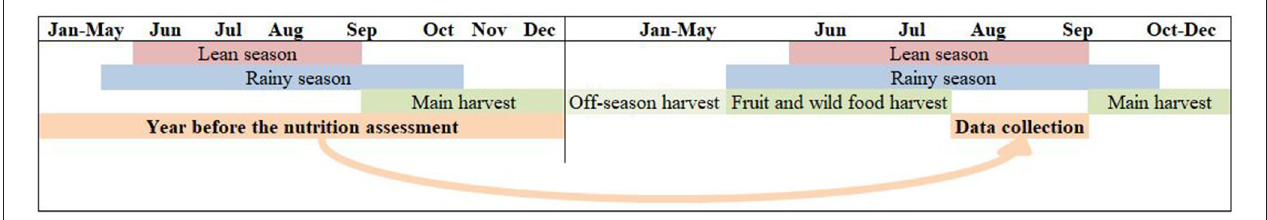
FIGURE 2 | Description of the study hypothesis based on the seasonal calendar of Burkina Faso. (adapted from Dixon & Holt (53)).